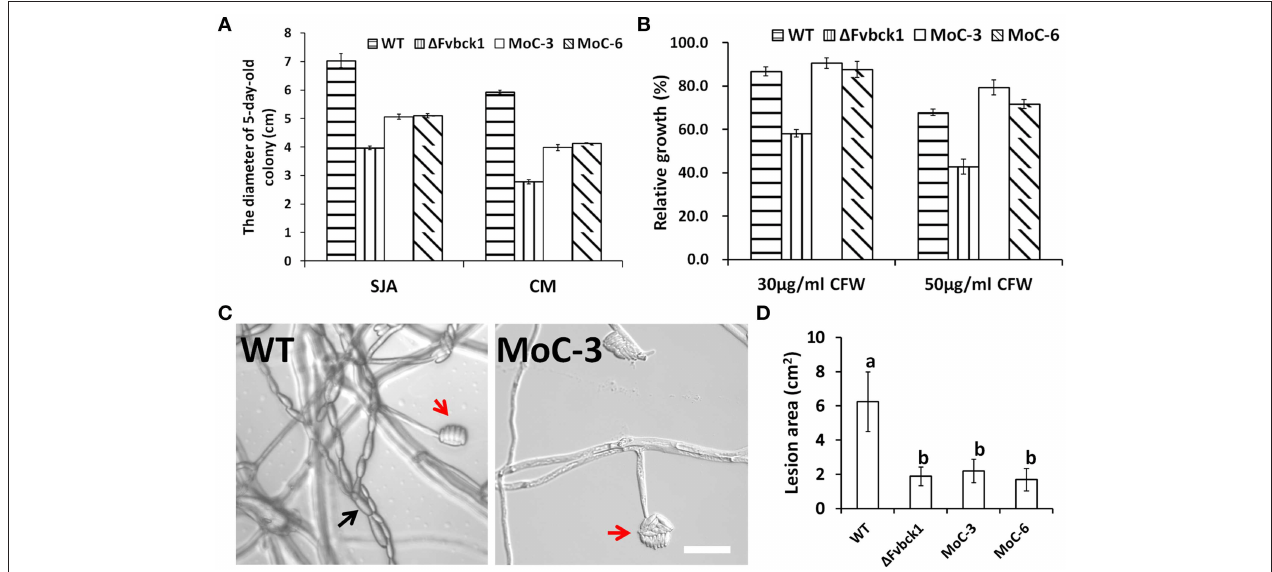
FIGURE 6 | Mck1 partially restored the defects of 1 Fvbck1. (A) Strains grown on SJA or CM plates for 5 days. (B) Relative growth of each strain grown on CM plates with different concentration of CFW at 26 ◦ C for 3 days. (C) Microconidiation of each strain grown on SJA plates for 5 days. Black and Red arrows indicate microconidial chain and false heads, respectively. Bar = 50 µ m. (D) Lesion area of longitudinally dissected sugarcane stalks infected by each strain for 7 days. Mean and standard error were calculated from three independent biological replicates. Different letters were used to mark statistically significant difference ( P < 0.05